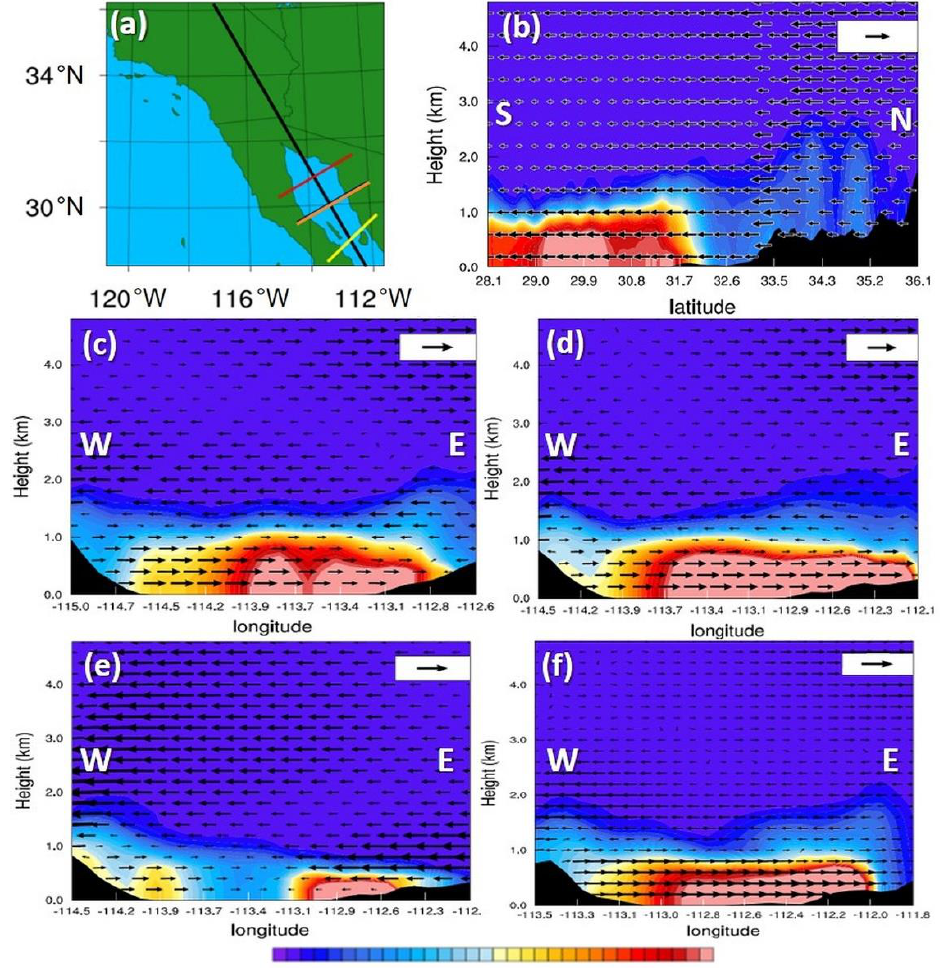
Figure 8. Cross sections of dust concentration ( µ g / m 3 ) and wind vectors with a magnitude reference of 10 m / s at 22:00 UTC on October 21. ( a ) location of cross sections, ( b ) Cross section from north to south (black line), ( c ) Cross section from west to east (red line), ( d ) Cross section from west to east (orange line), ( e ) Cross section from west to east at 08:00 UTC on October 22 (orange line) and ( f ) Cross section from west to east (yellow line).